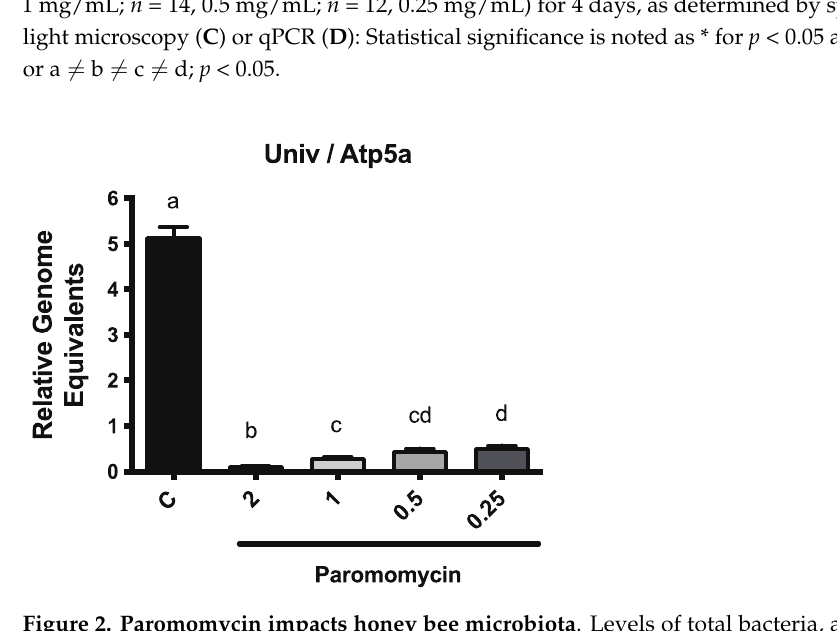
Figure 2. Paromomycin impacts honey bee microbiota . Levels of total bacteria, as determined by qPCR, in the midguts of infected newly emerged bees fed with a sucrose solution containing various doses of paromomycin for 4 days: a ≠ b ≠ c ≠ d; p < 0.05.